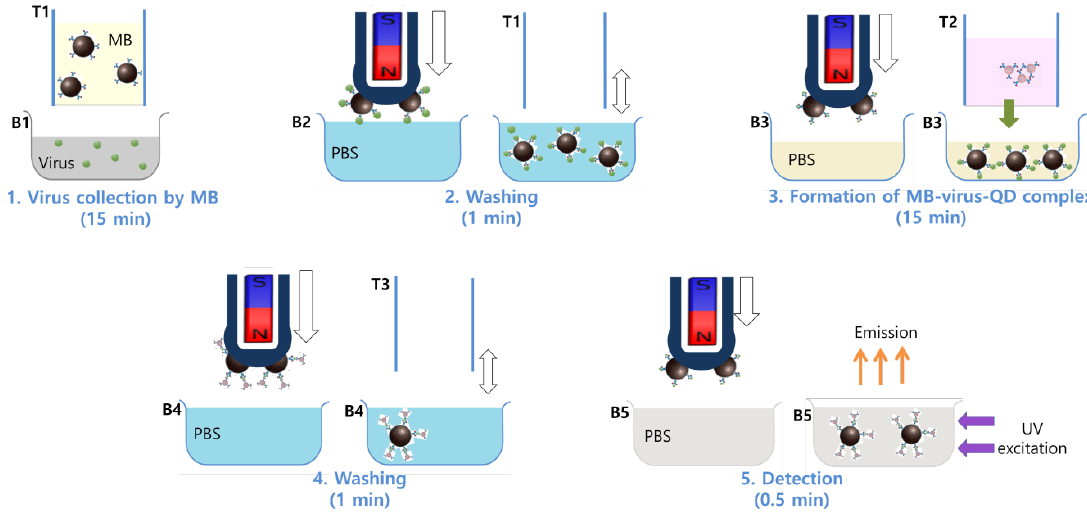
Figure 2. Schematic illustration of the sandwich immunoassay. The process consists of five steps. The reagent volumes are 70 µ L each for the MB solution (T1), QD 2 solution (T2), viral sample (B1), and PBS buffer (B3 and B5), and 210 µ L for each washing buffer (B2 and